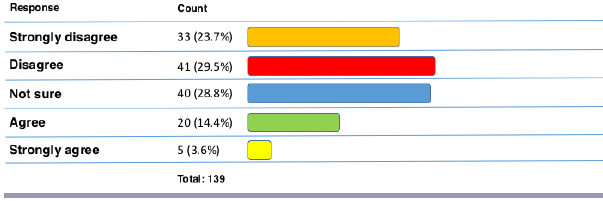
Fig. 9 . Participant responses to the statement, “After visiting the installation I feel my views on sustainability have changed.”